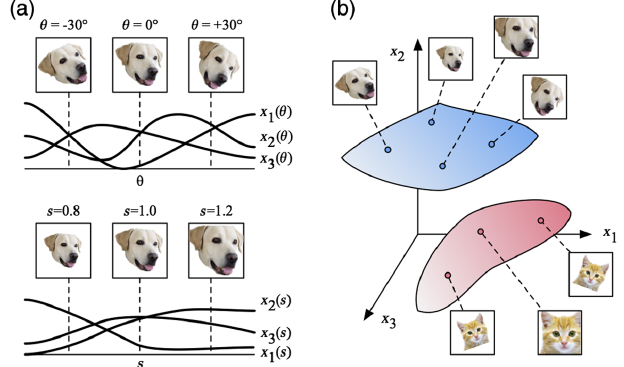
FIG. 1. Perceptual manifolds in neural state space.(a) Firing rates of neurons responding to images of a dog shown at various orientations θ and scales s . The response to a particular orientation and scale can be characterized by an N -dimensional population response. (b) The population responses to the images of the dog form a continuous manifold representing the complete set of invariances in the R N neural activity space. Other object images, such as those corresponding to a cat in various poses, are represented by other manifolds in this vector